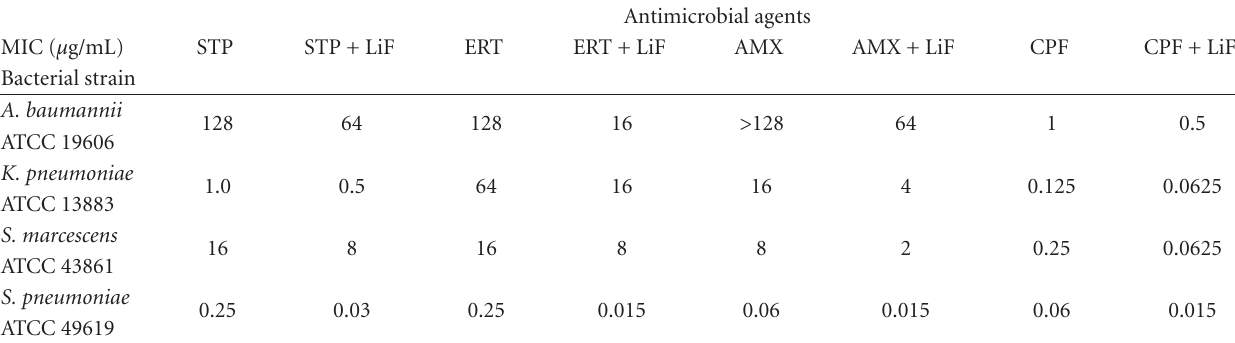
Table 2: MICs ( µ g/mL) of streptomycin, erythromycin, amoxicillin, and ciprofloxacin alone or in combination with LiF on planktonic Acinetobacter baumannii , Klebsiella pneumoniae , Serratia marcescens , and Streptococcus pneumoniae . Antimicrobial